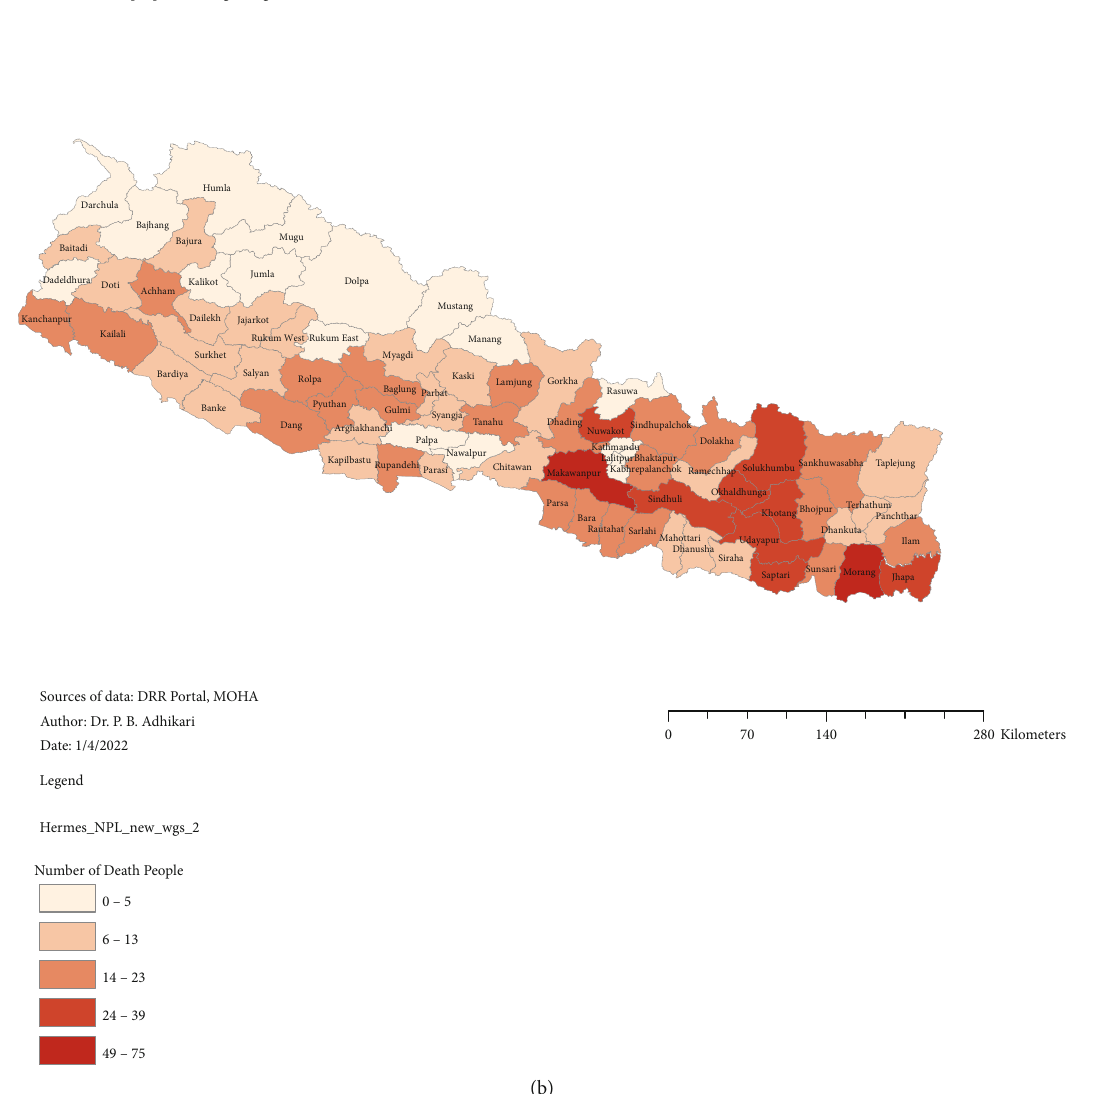
Figure 7: (a) The incident of the lightning and (b) the death of the people due to the lightning thunderstorm in the seventy-seven districts are presented with a color